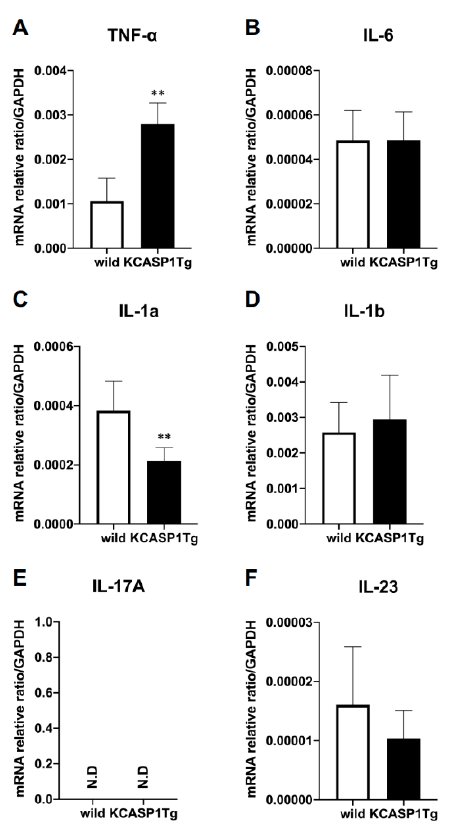
Figure 2. Inflammatory cytokine mRNA expression in the femur. The mRNA expression of Figure2. InflammatorycytokinemRNAexpressioninthefemur. ThemRNAexpressionofinflammatory inflammatory cytokines in the femurs was quantified using RT-PCR ( n = 6 per group). The cytokines in the femurs was quantified using RT-PCR ( n = 6 per group). The inflammatory inflammatory cytokines TNF- α , IL-6, IL-1 α , IL-1 β , IL-17A, and IL-23 a were measured and standardized using GAPDH. In the KCASP1Tg mice, TNF- α expression was significantly increased